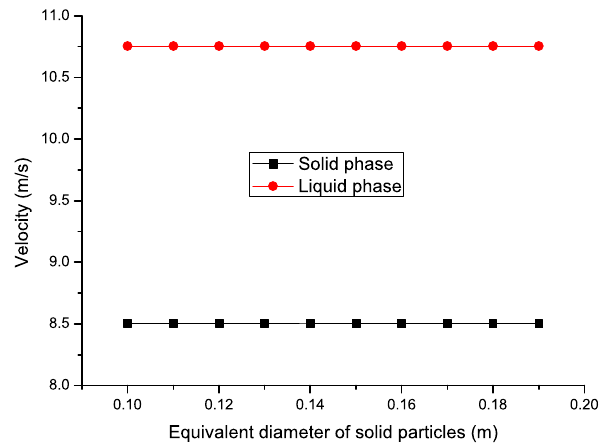
Figure 4. Solid- and liquid-phase velocities of a debris flow at the channel position x = 300m for different values of the solid equiv- alent diameter parameters: ρ s = 2400kgm − 3 , ρ f = 1500kgm − 3 , d e = 0.10–0.19m, ϕ s = 0.10, θ = 30 ◦ , ( τ B + µb)d 0 = 100, k = 3.72, g =